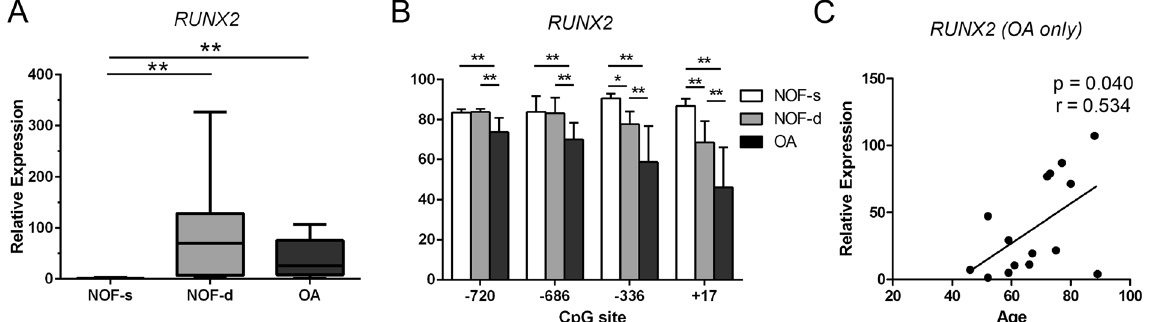
Figure 2. Higher levels of RUNX2 mRNA in deep zone NOF and OA chondrocytes than in superficial zone NOF chondrocytes are associated with the methylation status of specific CpG sites in the RUNX2 P1 promoter. ( A ) Relative mRNA levels of RUNX2 in the superficial (NOF-s) and deep zone (NOF-d) of NOF cartilage and OA cartilage were analysed by qRT-PCR and normalized against GAPDH. ( B ) Percentage methylation of the indicated CpG sites in the RUNX2 P1 promoter were analysed in genomic DNA simultaneously extracted from the same subjects by bisulfite pyrosequencing. The y-axis indicates non-adjusted percentage methylation. ( C ) RUNX2 mRNA levels in OA chondrocytes are plotted against the ages of subjects. Values are the mean ± SD. * P < 0.05, ** P <